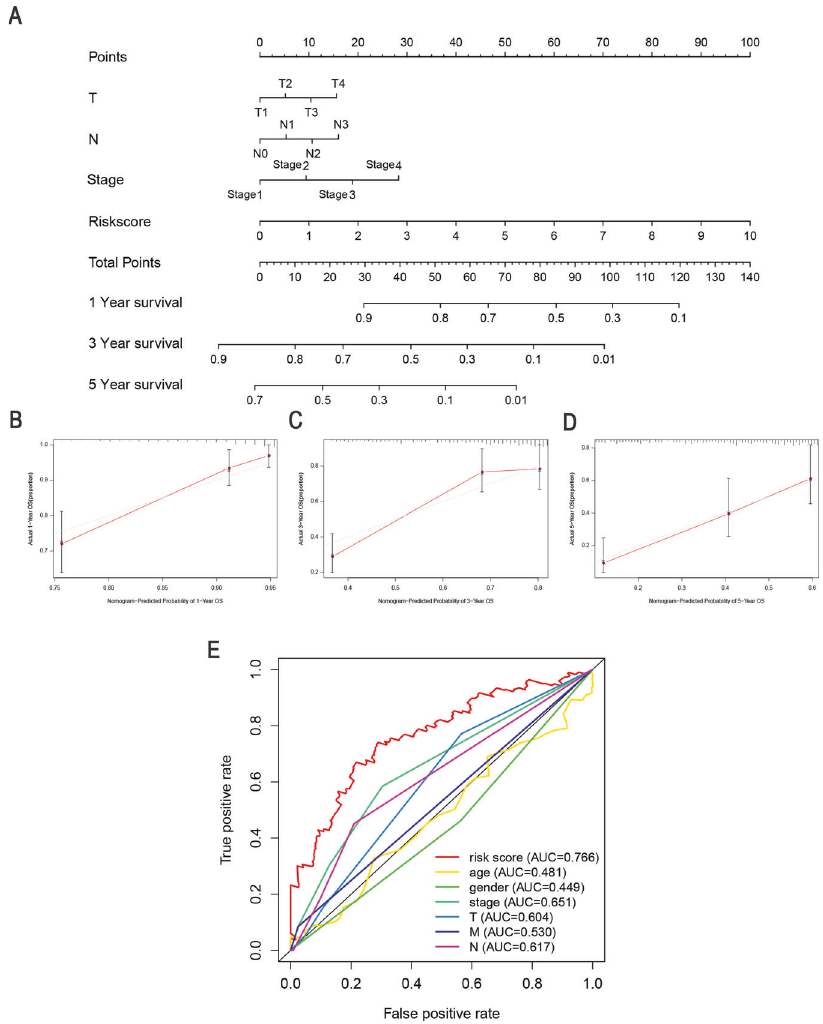
Fig. 6 Clinical prognostic nomogram for survival prediction. A A clinical prognostic nomogram was developed to predict 1-, 3-, and 5-year survival. Calibration curves showing nomogram predictions for 1-year ( B ), 3-year ( C ), and 5-year ( D ) survival. E Time-dependent ROC curve analyses for predicting OS at 5 years by risk score age, sex, stage, T stage (tumor size), M stage (distant metastasis), and N stage (lymph node metastasis). differed between the two risk groups (Fig. S1B, where colors ranging from green to red represent the in fi ltration density from low to high). Patients with LUAD in the high-risk group had higher ratios of activated memory CD4 T cells ( P < 0.001), M0 macro- phages ( P < 0.001), M1 macrophages ( P = 0.002), and activated mast cells ( P = 0.005). In contrast, memory B cells ( P = 0.047), plasma cells ( P = 0.023), monocytes ( P = 0.001), resting dendritic cells ( P < 0.001), resting mast cells ( P < 0.001), and monocytes ( P = 0.002) were negatively correlated with the risk score (Fig. 8A). The substantial immune in fi ltration observed in the low-risk group partly re fl ected the reduction in malignancy and effects of various treatments, indicating that our signature is not only a prognostic marker but also re fl ects levels of immune cell in fi ltration. The expression levels of immune checkpoints and/or their ligands may constitute predictive biomarkers for immune checkpoint blockade therapy. We further investigated the relationship between the levels of 29 immune checkpoint inhibitor (ICI) genes and the two risk groups strati fi ed by FerRLSig. Low-risk patients tended to express higher levels of 25 immune checkpoint genes, including ADORA2A, BTLA, CD160, CD200R1, CD244, CD28, CD40LG, CD70, CD80, CD86, HAVCR2, ICOS, IDO2, TIGIT, TNFRSF14, TNFRSF25, TNFSF14, TNFSF15 ,